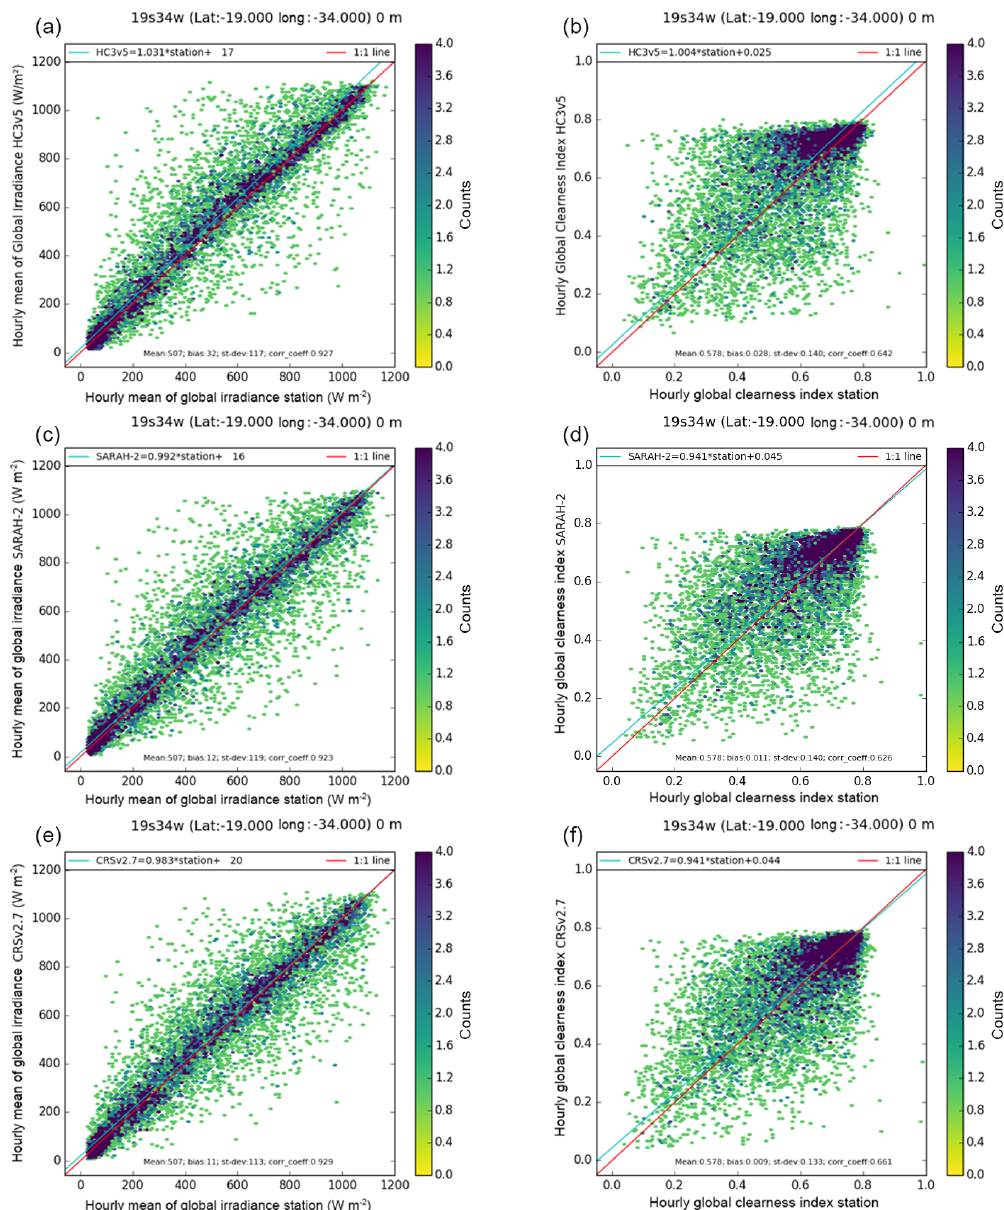
Figure D1. The 2-D histograms of PIRATA measurements (horizontal axis) and data sets (vertical axis) at 19 ◦ S, 34 ◦ W for E and KT. HC3v5: (a) and (b) ; SARAH-2: (c) and (d) ; CRS: (e) and (f) . Ideally, the dots should lie along the red line (1:1 line). The blue line is the affine function fitted over the points and should ideally overlay the red